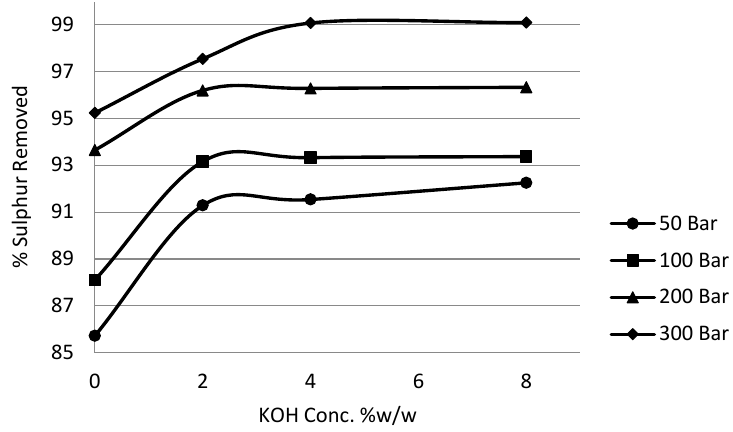
Figure 14. Effect of KOH concentration on pyritic sulphur removal.